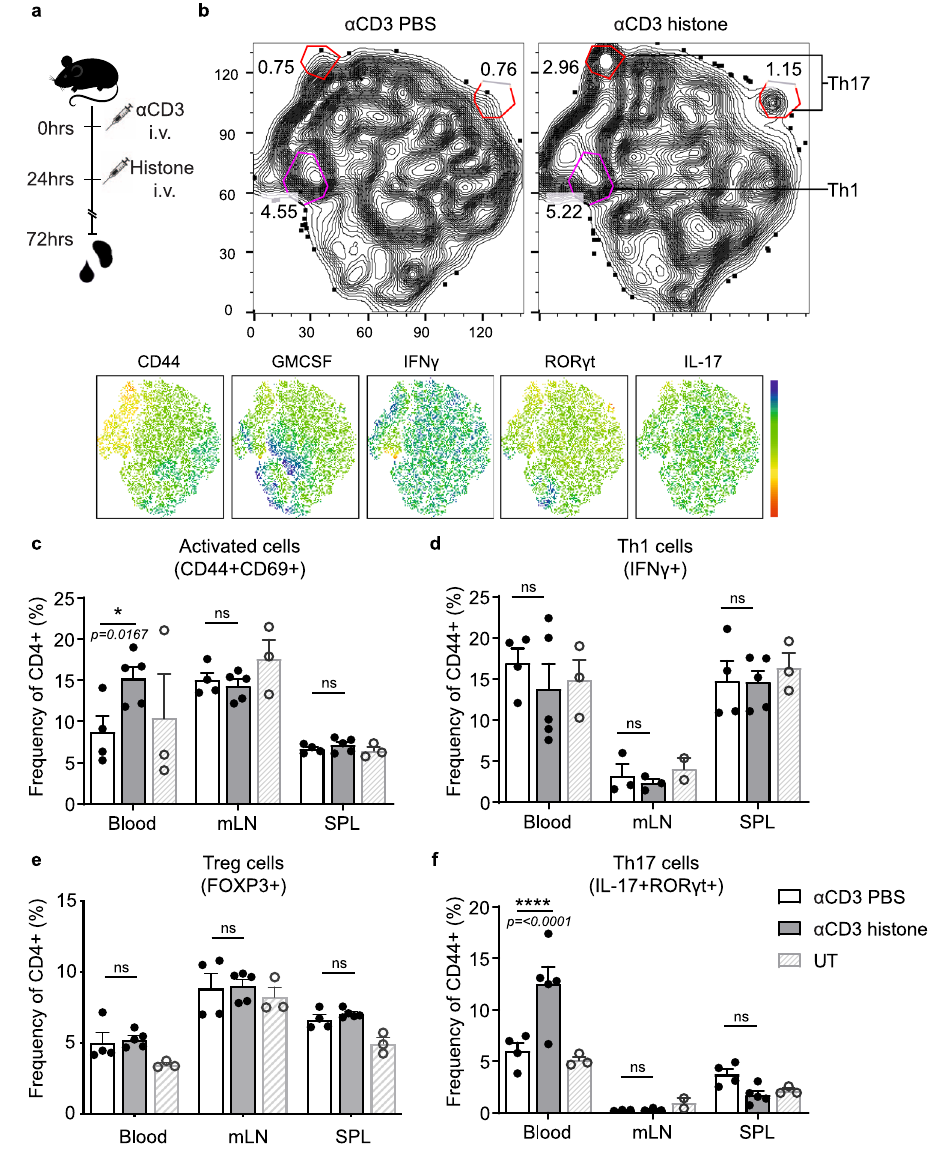
Fig. 2 Histone induction of Th17 cell response is conserved in vivo. a Histones were injected intravenously 24 h after injection of low dose α CD3 and 48 h later blood and lymphoid organs were analyzed. b TsNE analysis of fl ow cytometric data of CD4 + T cells with clustering based on the production of cytokines and expression of CD44. Th17 cell populations (top red circles) and Th1 cell populations (bottom pink circle) are highlighted. Quanti fi cation of c activated CD4 + T cells, d Th1, e Treg, and f Th17 cells based on conventional gating of fl ow cytometry data was also performed. Data bars show mean ± SEM. “ ns ” (not signi fi cant), p > 0.05; “ * ” p < 0.05; “ **** ” p < 0.0001. c – e Two-way ANOVA with Dunnett ’ s multiple comparisons test. Data points represent individual mice. All data are representative of a minimum of two independent experiments. Source data are provided as a Source Data fi